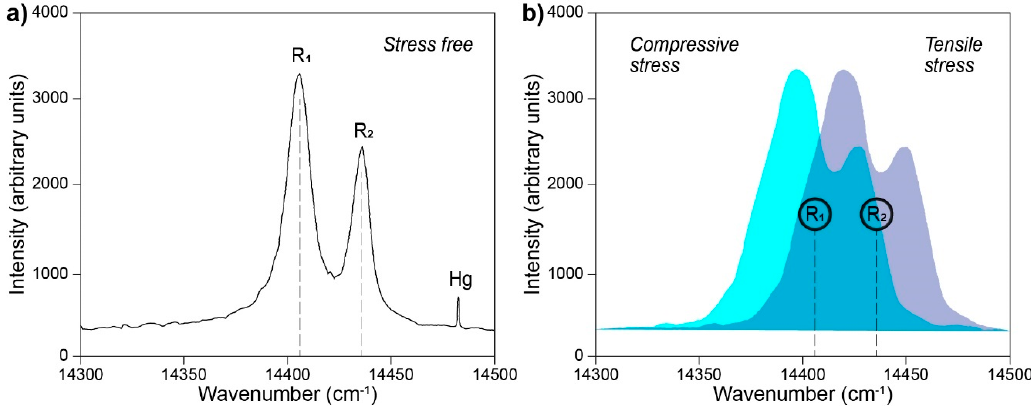
Figure 11. Photoluminescence piezospectroscopy spectra: ( a ) spectrum of polycrystalline Al 2 O 3 resulting from the native presence of Cr 3+ impurities and ( b ) hypothetical spectra of the material under compressive (cyan) and tensile (violet) stress with respect to the optical levels R 1 and R 2 (in circles) assigned from ( a ). Figure ( a ) adapted with permission from [85].